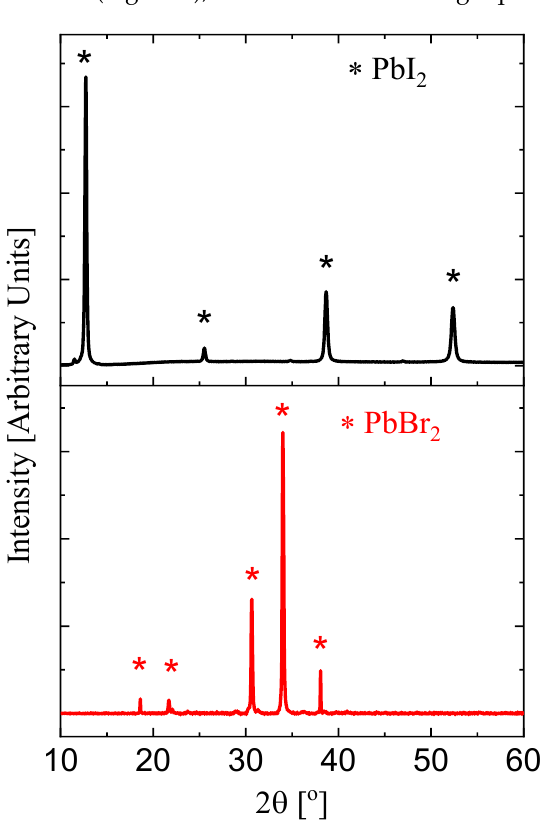
Figure 1. XRD of films under study: PbI 2 — upper panel, PbBr 2 — lower panel. For photochemical aging, an LG sulfur plasma lamp (LG, Seoul, Republic of Korea) was used as a light source which provides a good approximation to the AM1.5G solar spectrum. Wavelengths below 350 nm were cutoff using an additional UV filter. The light power on the samples was ~70 mW/cm 2 at a temperature of 45 ± 2 ◦ C. The absorption spectra were measured with an AvaSpec-2048-2 UV-VIS fiber spectrometer built into the glove